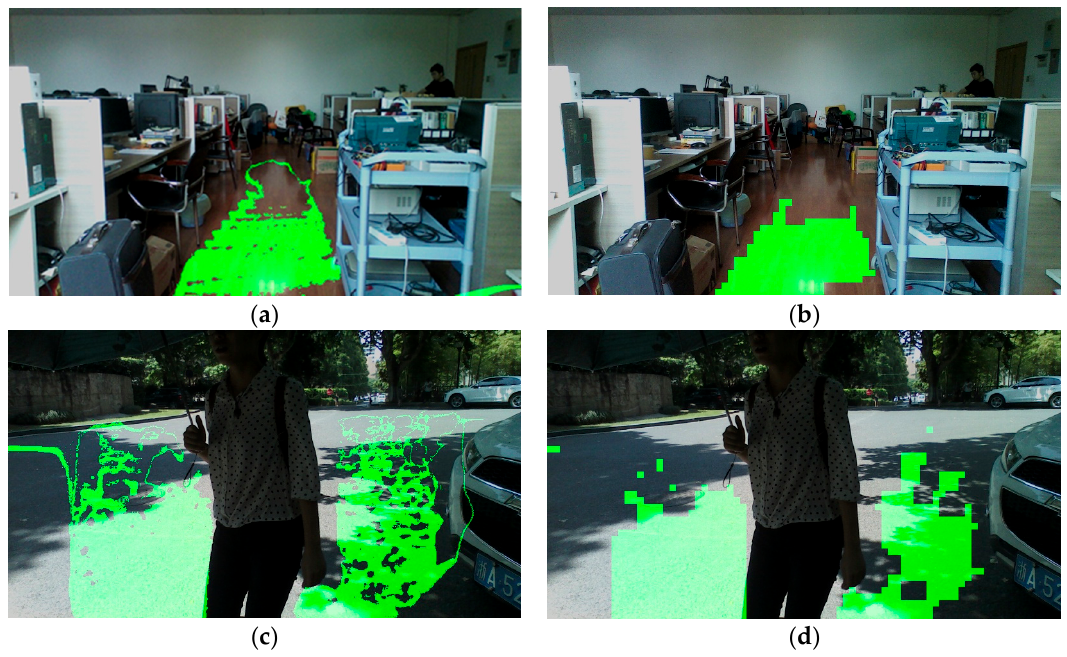
Figure 6. Ground plane segmentation in indoor and outdoor environments. ( a , c ) Ground plane detection based on the RANSAC algorithm; ( b , d ) salient parts in the ground plane are dismissed with surface normal vector estimation.